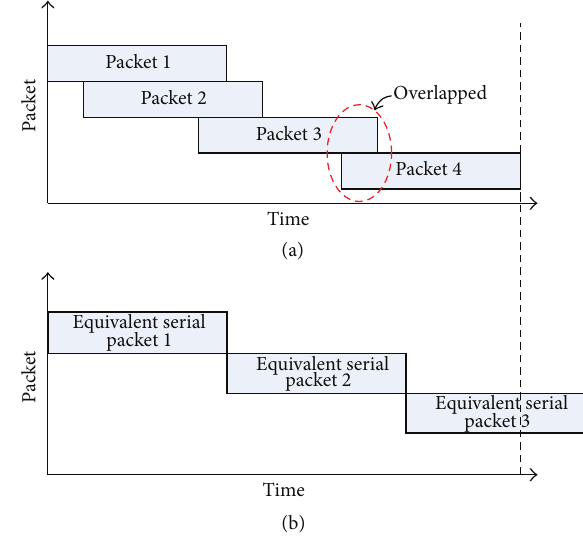
Figure 3: Packets in a communication issued by a processor